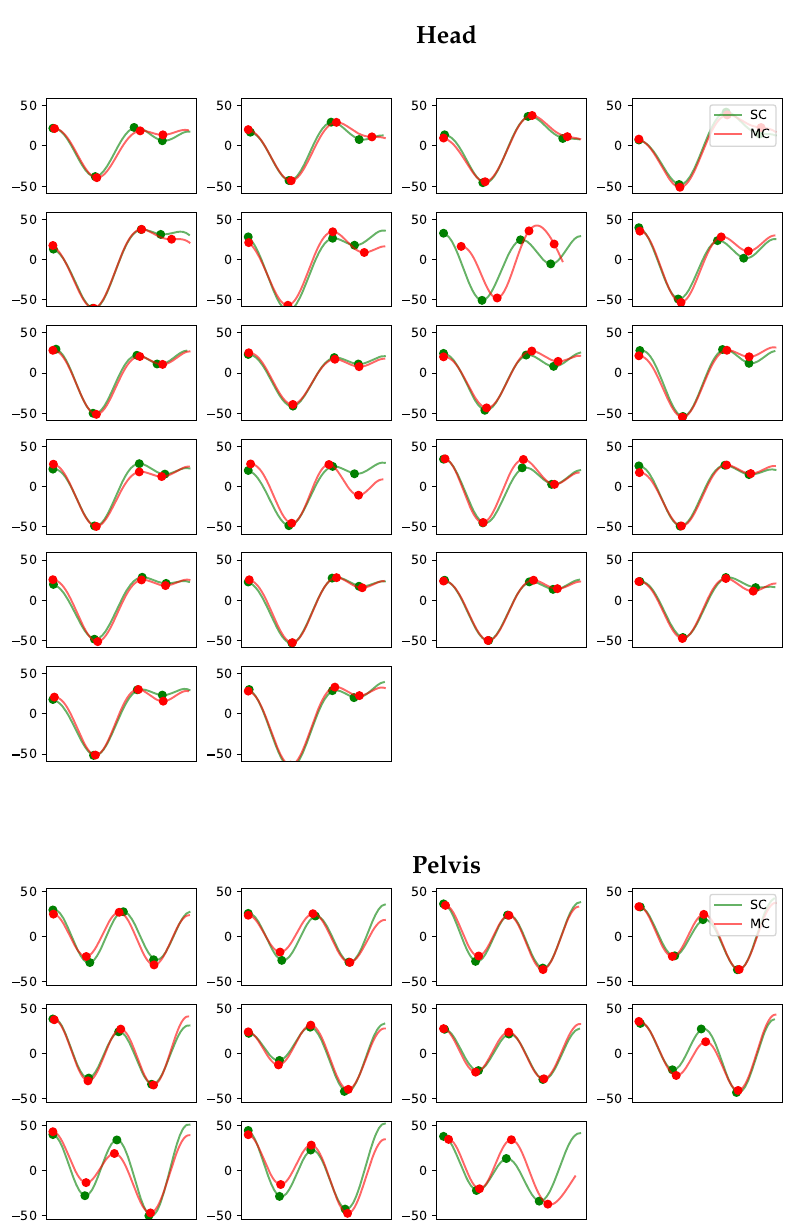
Figure A12. Vertical displacement signals per stride for the head and pelvis for horse 13. Each subplot contains the matched stride segments for the single-camera markerless system (SC) in green and the multi-camera marker-based system (MC) in red. The y-axis shows the vertical displacement in millimeters. The four dots on each curve indicate the positions of the two peaks and two valleys extracted using the approach in Section